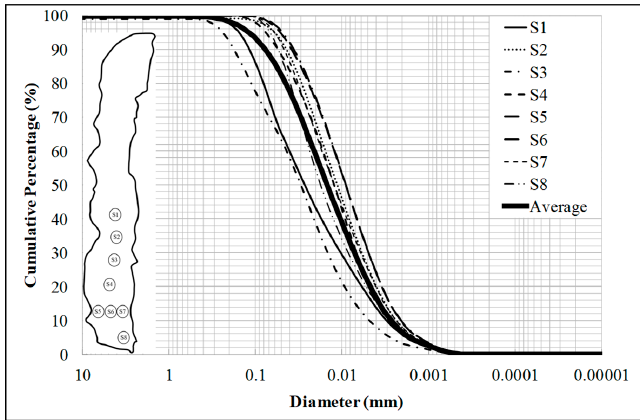
Figure 4. Grain size distribution from samples collected in the lower Wushe Reservoir.